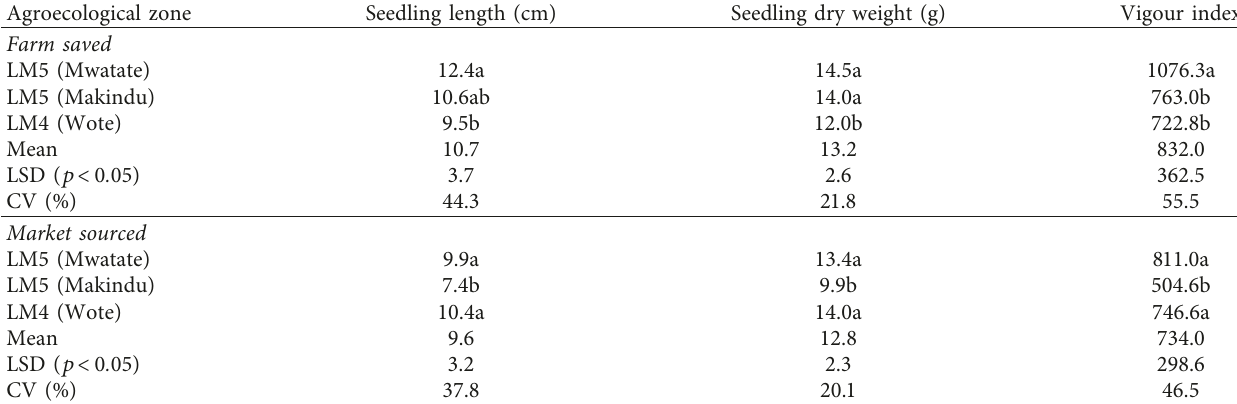
Table 7: Vigour of farm-saved and market-sourced seeds from different agroecological zones in Makueni and Taita Taveta. Agroecological